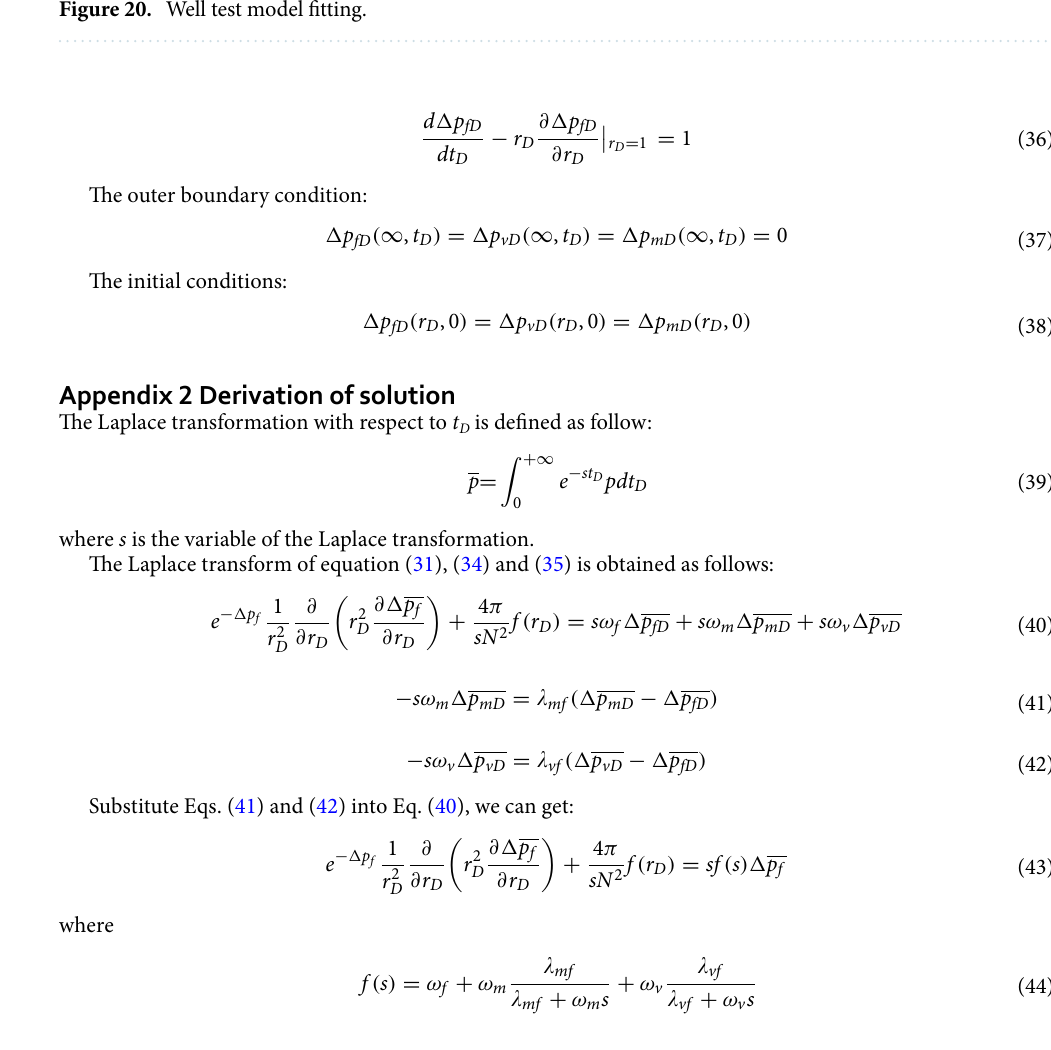
Figure 20. Well test model